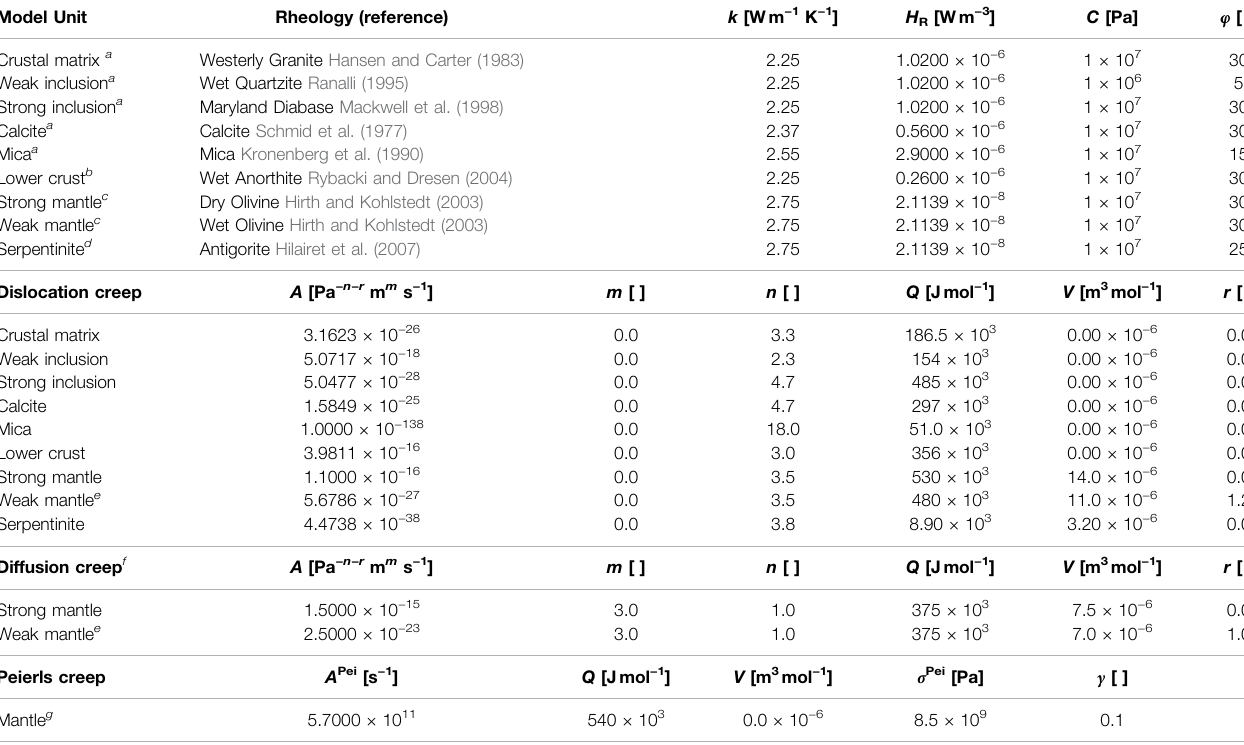
TABLE 1 | Physical parameters used in the numerical simulations. Model